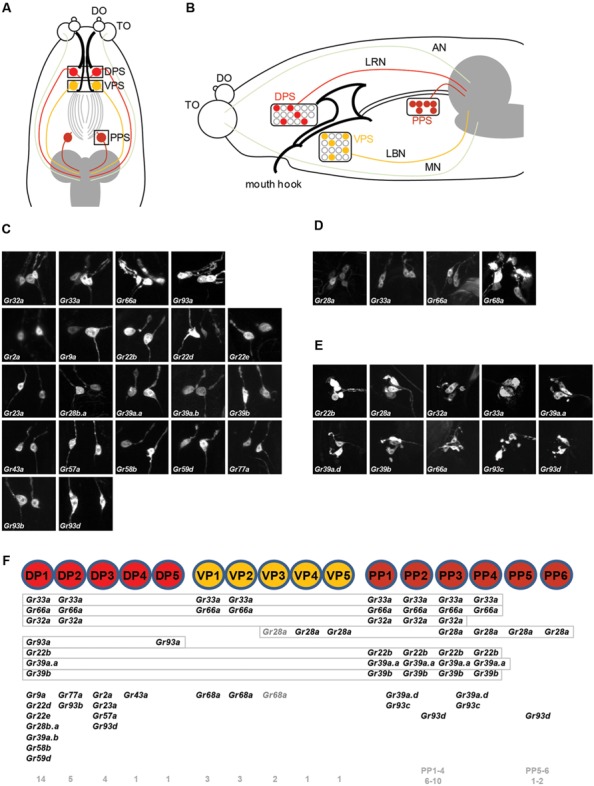
A gustatory receptor-to-neuron map in the pharyngeal sense organs of Drosophila larva. (A,B) The taste system of the larval head. (A) shows a dorsal view, with anterior to the top and (B) shows a lateral view, with anterior to the left. The ventral organs and ganglia of the taste organs were omitted from the schematics for simplicity. The boxes in (A) represent the positions at which micrographs were taken for the DPS (C), VPS (D), and PPS (E). The DPS was drawn anterior to the VPS for convenience of representation, and does not reflect the actual relative positions of the DPS and VPS. The colored pharyngeal sensory neurons in (B) represent the neurons for which gustatory receptor expression was mapped (F) and the positions of the cell bodies in the diagram are arbitrary. Among the neurons that innervate the TO, the TO-dorsolateral group projects through the antennal nerve and the TO-distal group projects through the maxillary nerve to the larval brain. DO, dorsal organ; TO, terminal organ; DPS, dorsal pharyngeal sensilla; VPS, ventral pharyngeal sensilla; PPS, posterior pharyngeal sensilla; AN, antennal nerve; LRN, labral nerve; LBN, labial nerve; MN, maxillary nerve. (C–E) Expression of Gr-GAL4 drivers in the pharyngeal sense organs. (C) The Gr32a-, Gr33a-, Gr66a-, and Gr93a-GAL4 drivers are expressed in two pairs of neurons in the DPS, and the remaining 17 Gr-GAL4 drivers are expressed in a single pair of neurons in the DPS. (D)
Gr28a- and Gr68a-GAL4 are expressed in three pairs of neurons in the VPS, and Gr33a- and Gr66a-GAL4 are expressed in two pairs of neurons in the VPS. (E) Ten Gr-GAL4 drivers showed GFP reporter expression in 1–4 pairs of neurons in the PPS, with weak and inconsistent expression from individual to individual. (F) Pharyngeal gustatory receptor (Gr)-to-neuron map. Co-expressed Gr-GAL4 drivers are listed for each neuron. The numbers on the bottom show the numbers of Gr-GAL4 transgenes expressed in each pharyngeal GRN. The number of Gr-GAL4-expressing cells in the VPS and PPS varies greatly from individual to individual, rendering it difficult to use combinations of Gr-GAL4 lines to directly observe neurons co-expressing certain drivers. Gray letters were used for Gr28a-GAL4 and Gr68a-GAL4 because we could not be sure that they co-express in VP3. Also, although we observed that PPS-expressing Gr39a.d-, Gr93c-, and Gr93d-GAL4 co-expressed with Gr33a-GAL4 expressing neurons, we could not verify co-expression between those transgenes, and so the transgenes were marked in a range underneath the PPS cells, rather than in definitive positions.